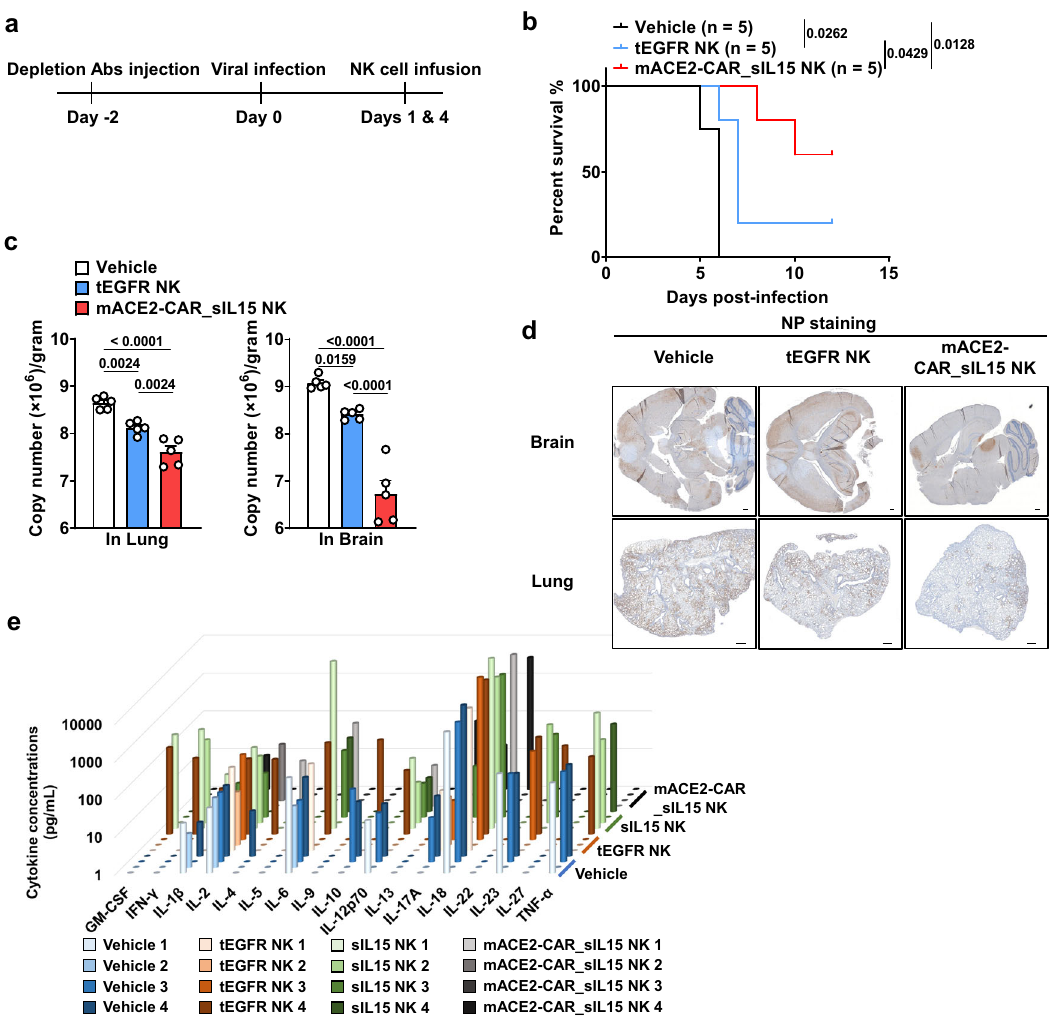
Fig. 5 mACE2-CAR_sIL15 NK cells protect against live SARS-CoV-2 infection in the K18-hACE2 humanized mouse model. a Scheme for in vivo studies using K18-hACE2 humanized transgenic mice. b K18-hACE2 humanized transgenic mice were infected with 1 × 10 3 plaque-forming units (PFU) of SARS- CoV-2 prior to being treated with the vehicle (PBS), control tEGFR NK cells, or mACE2-CAR_sIL15 NK cells. Survival of mice is summarized. N = 5 mice/ group. P values were determined by Kaplan – Meier survival analysis and calculated by the Gehan-Breslow-Wilcoxon test (two-sided). c Viral RNA levels are shown for brain and lung tissues of mice infected i.n. with 1 × 10 3 plaque-forming units (PFU) of SARS-CoV-2. N = 5 mice/group. P values were determined by one-way ANOVA with multiple comparisons and adjusted by the Holm-Sidak method. Data are presented as mean ± SEM. d Representative images of the three groups in b show immunohistochemistry (IHC) staining of coronavirus nucleocapsid protein (NP). Scale bars, 400 μ m. e Release assay of various cytokines into plasma of K18-hACE2 transgenic mice. Mice were infected with 1 × 10 3 PFU of live SARS-CoV-2 prior to being treated with the vehicle (PBS), control tEGFR NK cells, control sIL15 NK cells, or mACE2-CAR_sIL15 NK cells. Four days later, all mice were sacri fi ced to collect blood plasma to measure levels of the indicated cytokines by a cytokine release Luminex assay. N = 4 mice/group. Data are presented as an average of two replicates for each mouse. Source data are provided as a Source Data fi